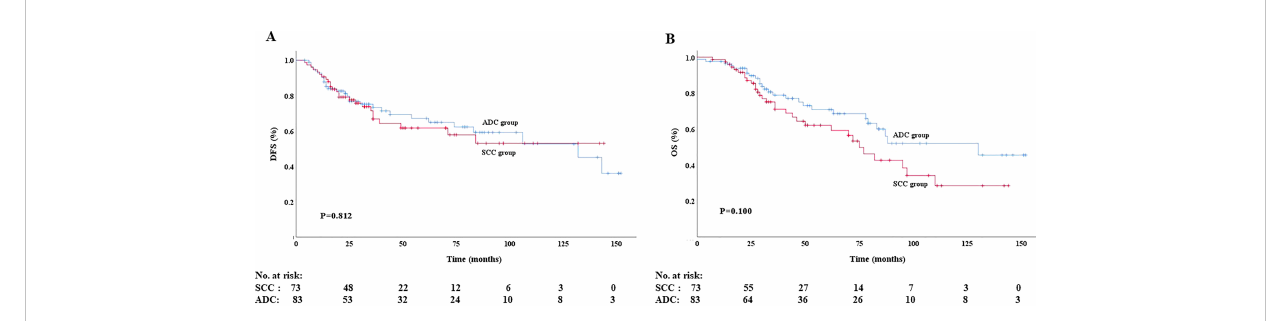
FIGURE 2 Disease-free survival (A) and overall survival (B) of patients in the ADC group and SCC